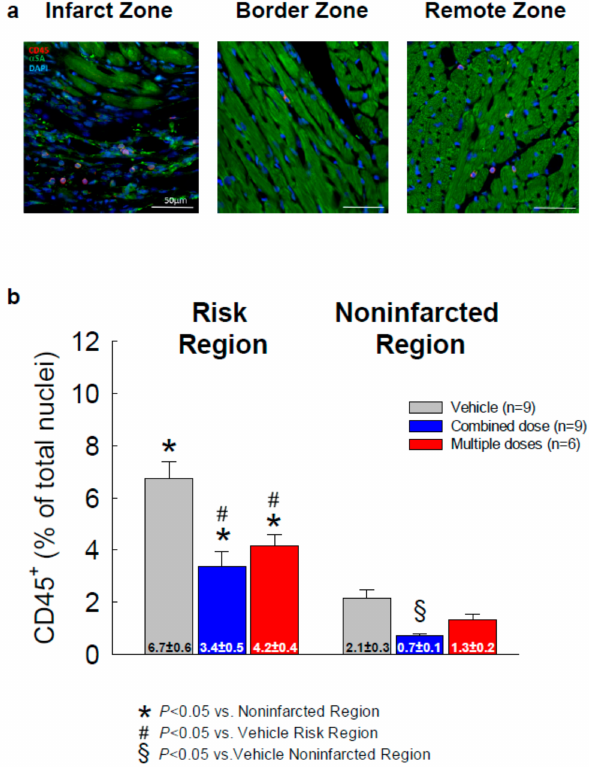
Figure 7. Myocardial content of inflammatory cells. ( a ) Representative microscopic images of LV sections stained for CD45 (red), α -sarcomeric actin (green), and DAPI (blue); ( b ) quantitative analysis of the number of CD45 + cells in the risk and noninfarcted regions expressed as a percentage of total cells counted in the corresponding region. All data are represented as the mean ±